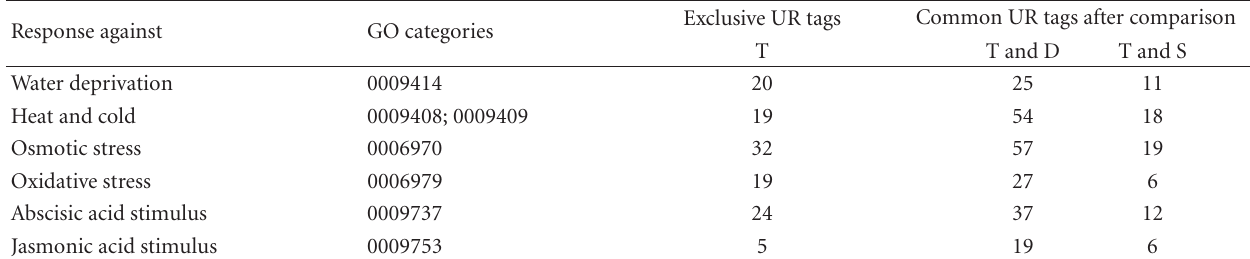
Table 2: Total number of sugarcane upregulated (UR) root tags observed on contrasting SuperSAGE libraries when associated with ESTs classified by Gene Ontology (GO) in the subcategories related to abiotic stress response.